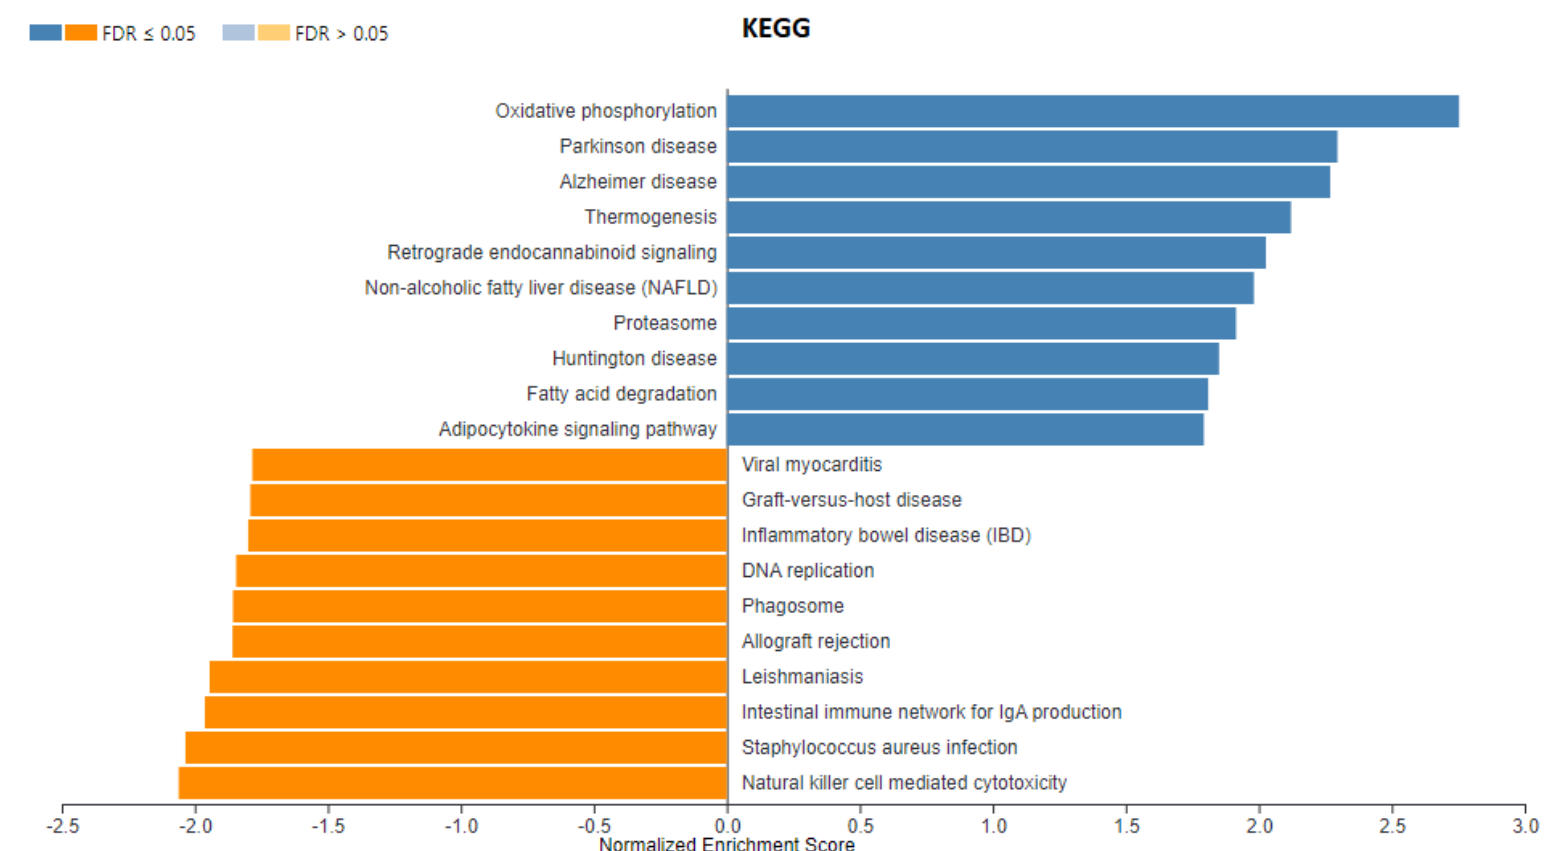
Figure 5. Enriched KEGG pathways (Sus scrofa) identified in the rapeseed oil vs. beef tallow dataset by WebGestalt software. Positive normalized enrichment score indicates that genes from the pathway are at the top of the ranked list (mostly upregulated). Negative normalized enrichment score indicates that genes from the pathway are at the bottom of the ranked list (mostly downregulated) (the first group in the comparison is the reference group).